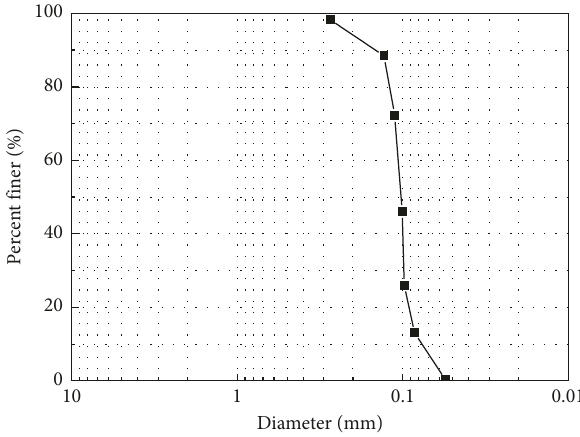
Figure 3: Grain size distribution of test sand.